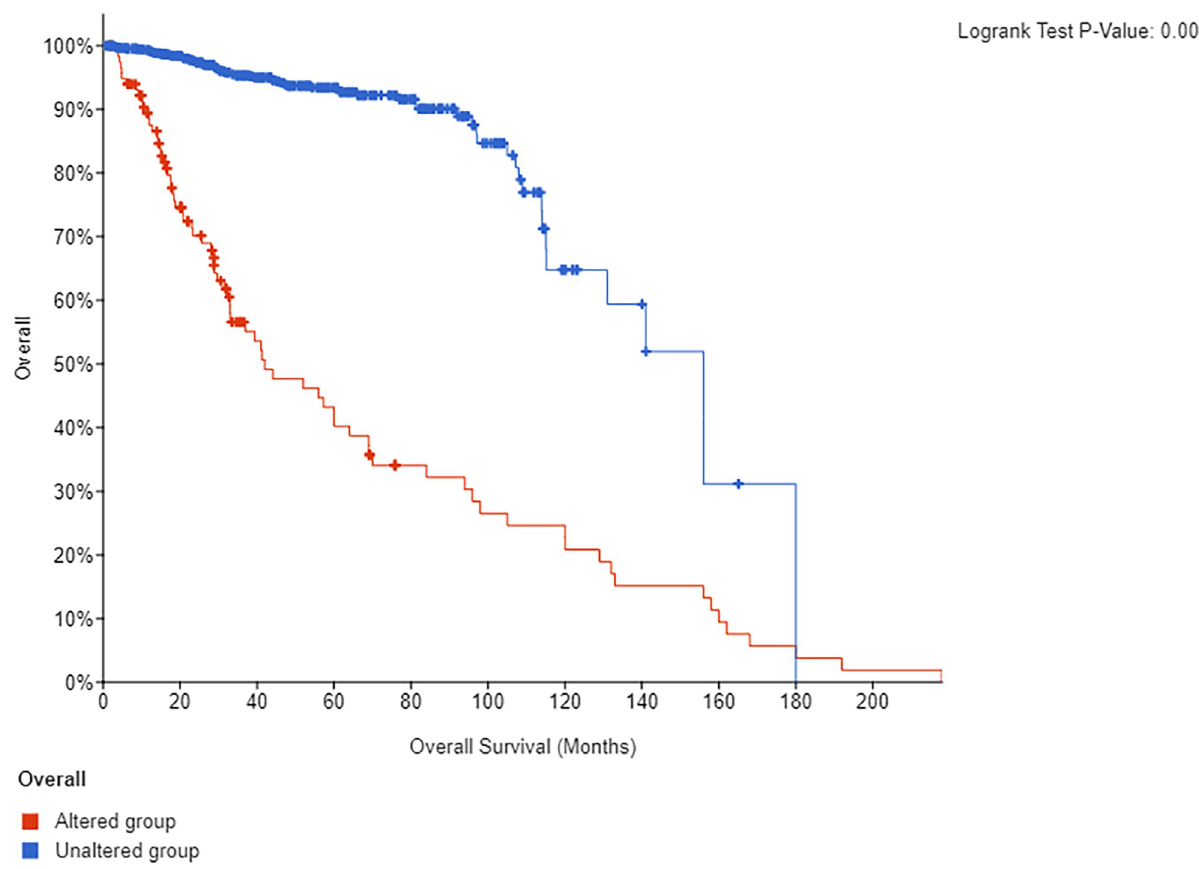
Fig 9. Survival analysis of AR. Survival analysis involves AR gene. The blue line in the figure indicates the survival of prostate cancer patients whose targets had not changed. Non-blue lines show changes in the survival of prostate cancer patients with changed targets.